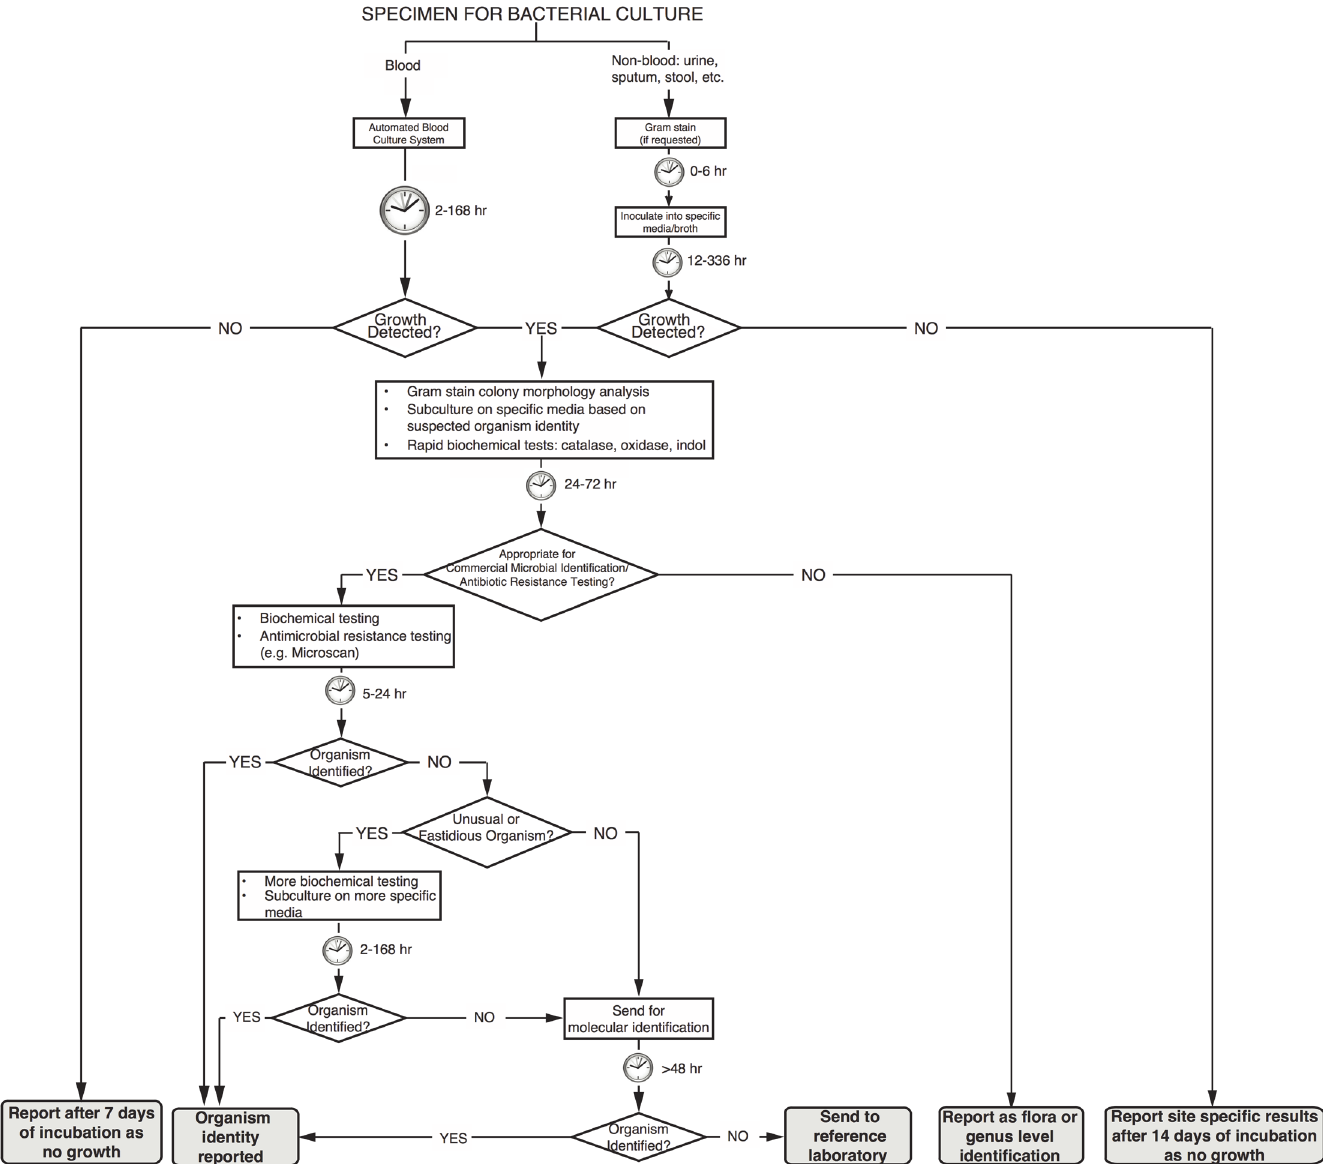
Fig 1. Bacterial identification by clinical microbiology laboratory techniques. Typical temporal workflow of clinical microbiological laboratory to identify microbes from clinical samples based on phenotypic, biochemical, and culture-based techniques.